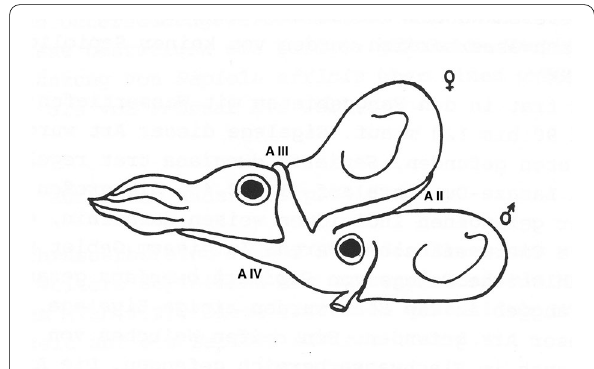
Fig. 1 Mating in Sepiola affinis , Sepiola intermedia and Sepietta obscura (drawing © Adrianne